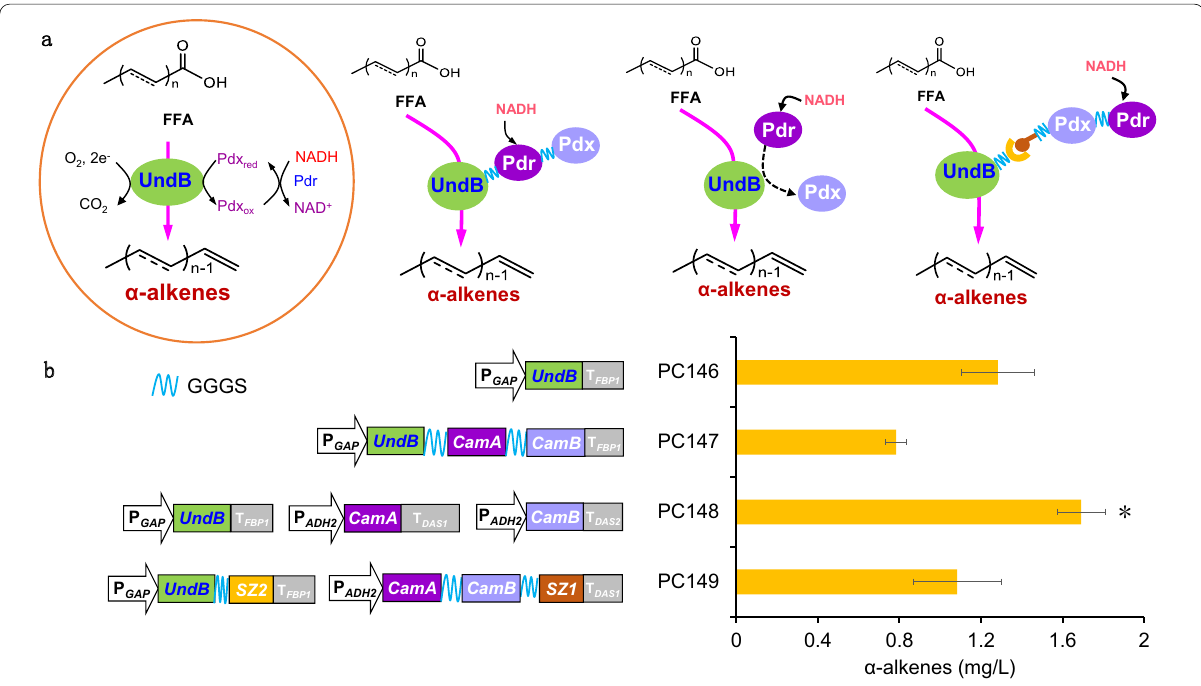
Fig. 2 Cofactor engineering for the biosynthesis of α-alkenes. a Schematic diagram of different constructed interactions between cofactor and UndB. b Total α-alkenes production in engineered strains in shake flask after 96 h cultivation in 20 g/L glucose medium. All data were represented as the mean s.d. of three samples. Statistical significance of the different α-alkenes levels in comparison with the control (PC146) was evaluated by ± using Student’s t -test (* P < 0.05; ** P <